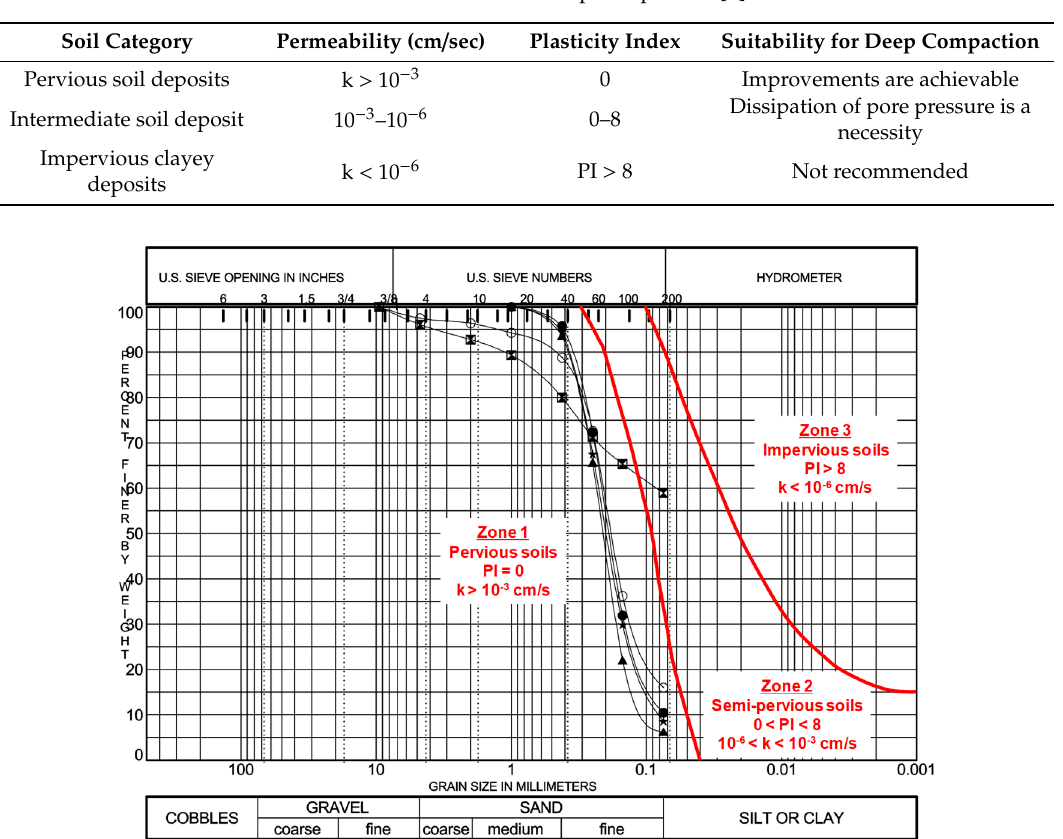
Table 2. Soil suitable for deep compaction [4].